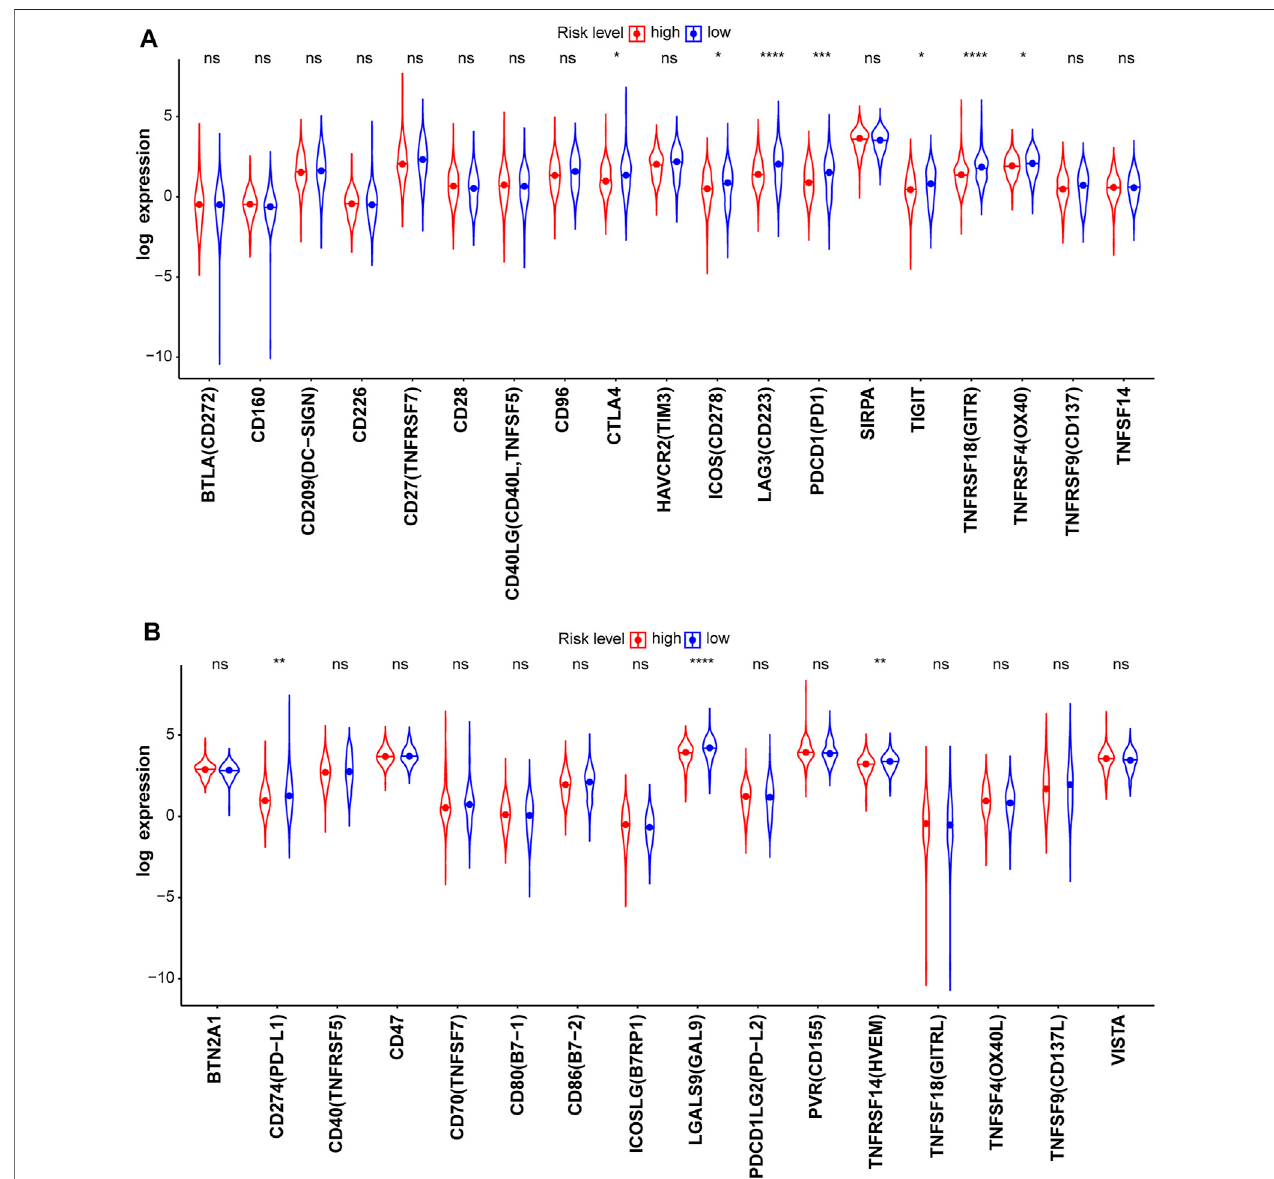
FIGURE 10 | Known immune checkpoints (A) and their ligands (B) in the test2 cohort.